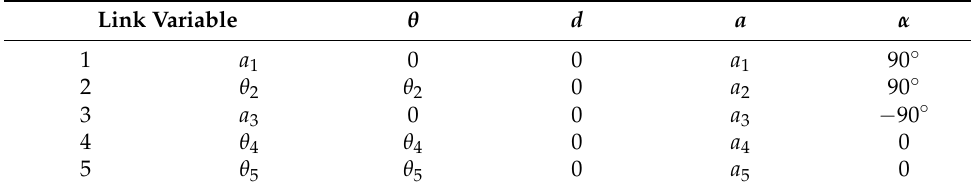
Table 1. The obtained D–H